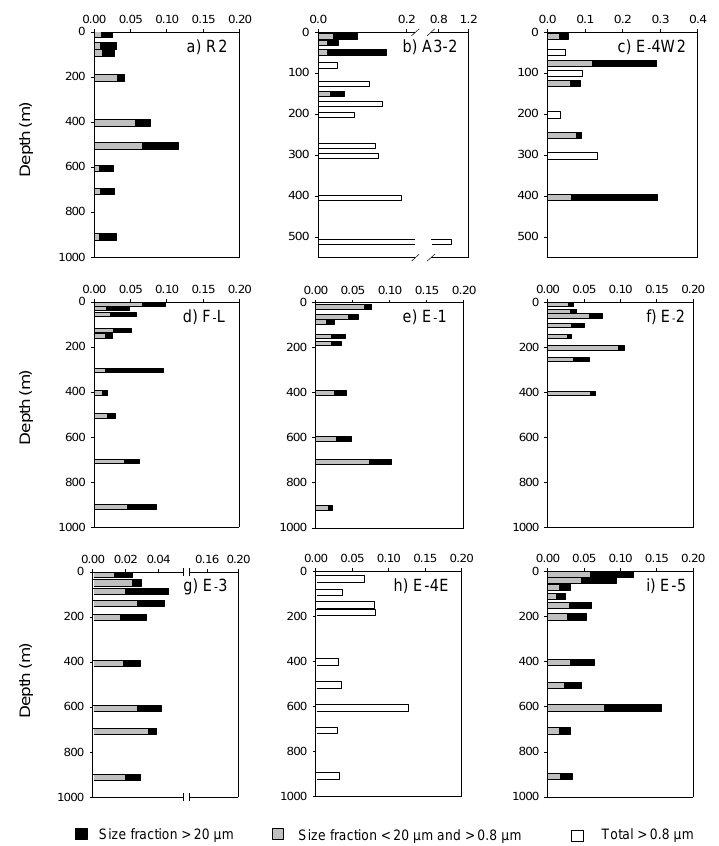
Figure 15. Figure 15. Vertical profiles of lithogenic silica (LSi) concentrations for three size fractions (>0.8µm, between 0.8 and 20µm and >20µm) at stations R2 (a) , A3-2 (b) , E-4W2 (c) , F–L (d) and at stations E: E-1 (e) , E-2 (f) , E-3 (g) , E-4E (h) , E-5 (i)